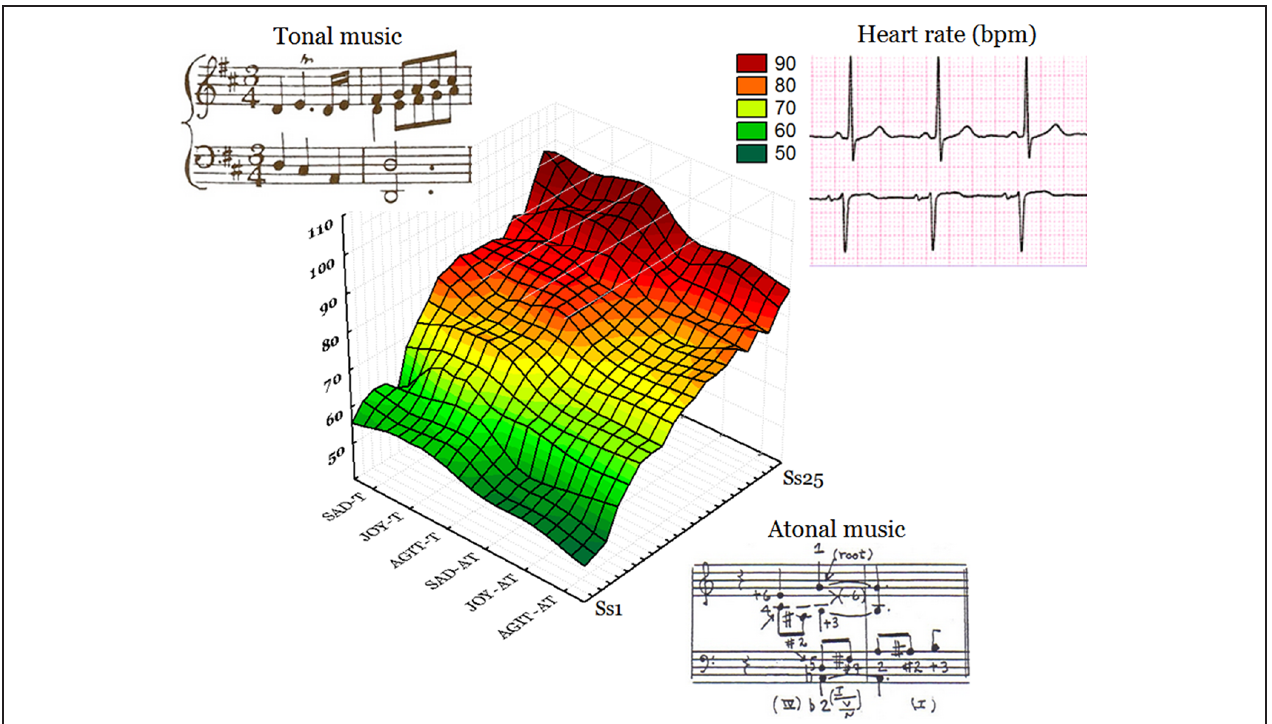
FIGURE 5 | Individual values of heart frequency recorded in healthy university students while listening to tonal or atonal musical pieces. The latter condition was associated with a pronounced bradycardia (represented by a more extended green and yellow area). AGIT-AT = atonal agitating; JOY-AT = atonal joyful; SAD-AT = atonal touching; AGIT-T = tonal agitating; JOY-T = tonal joyful; SAD-T = tonal